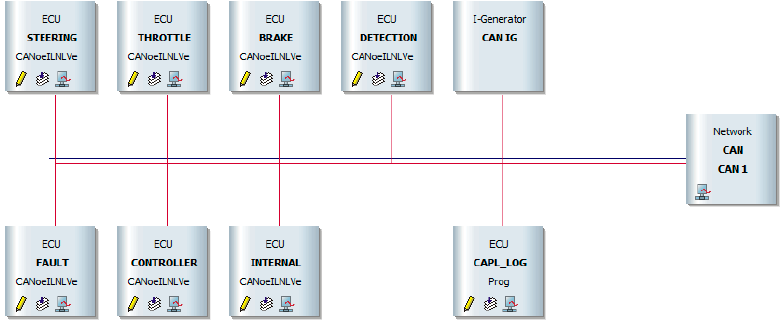
Figure 3. Setup of communication created in CANoe which mimics vehicle CAN bus.